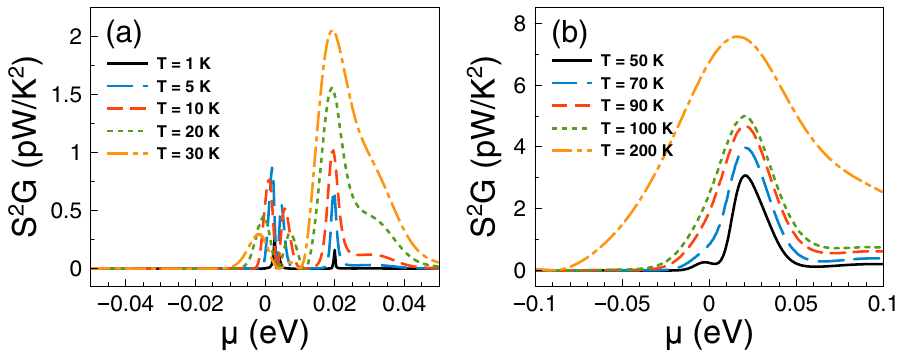
Figure 11. Power factor versus chemical potential for gapless bilayer graphene double barriers at different temperatures: ( a ) from 1 to 30 K and ( b ) from 50 to 200 K. The double barriers structural parameters are the same as in Fig. 9. In this case, at low temperatures, there is a competency between the charge neutrality point and Breit–Wigner resonance with the Fano resonances energy region. However, as the temperature increases the Fano resonances dominate the power factor characteristics.